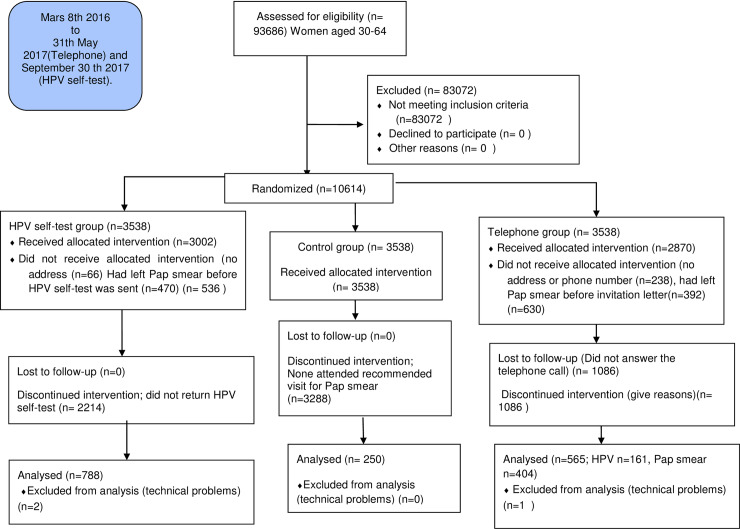
Study population.